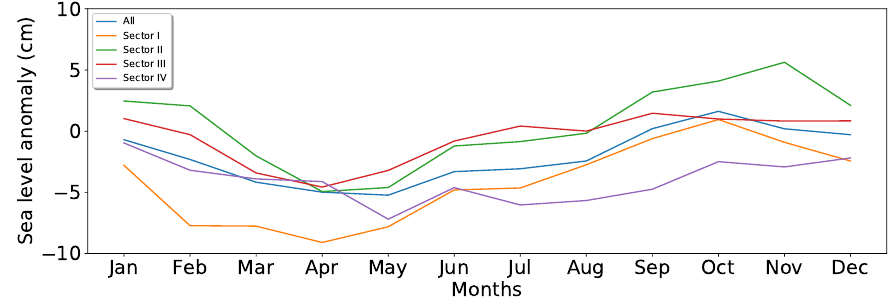
Figure 10. The mean value for all months in the interval 1996–2019 for the entire Arctic Ocean (blue) and the different regions outlined in Figure 1: Sector I (orange), II (green), III (red), IV